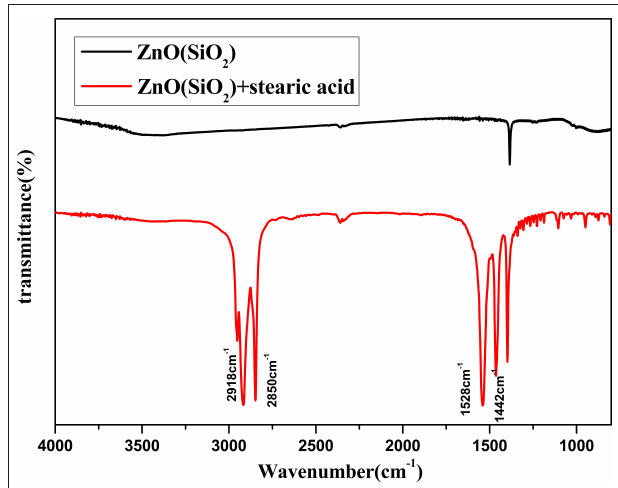
FIGURE 7 | FITR spectra of SiO 2 shell on ZnO nanorod arrays before and after modification by stearic